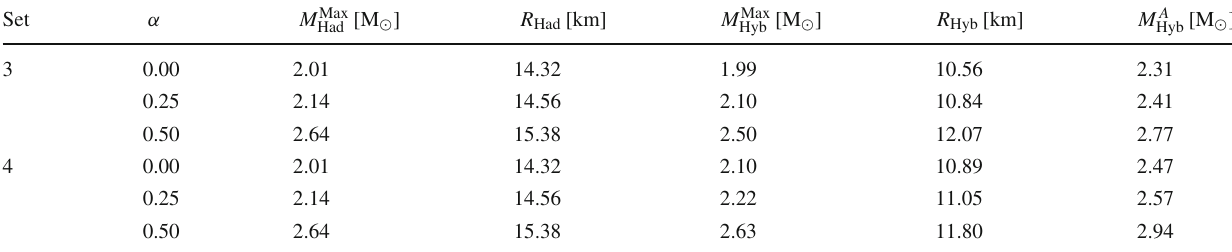
Table 2 Maximum gravitational masses for the hadronic (Had) and hybrid (Hyb) configurations with corresponding radii for distinct sets of the MP model. We also present the baryonic mass M A for the hybrid configurations [ M (cid:2) Set α M Max Had